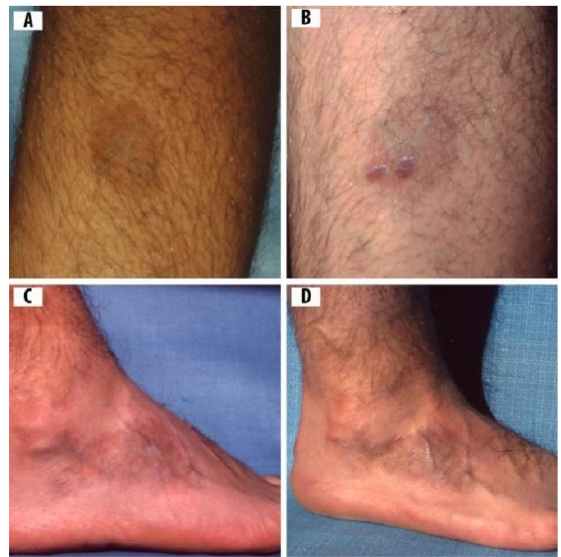
Figure 4. A 14-yr-old boy with rashes compatible in appearance with ACA: ( A ) ACA rash on the calf of right leg before skin biopsies; ( B ) skin biopsies test positive for Borrelia burgdorferi sensu lato (Bbsl) by polymerase chain reaction (PCR); ( C ) ACA on right foot with pronounced swelling and reddish-blue discoloration; and ( D ) hyperpigmented, atrophic ACA on right foot.